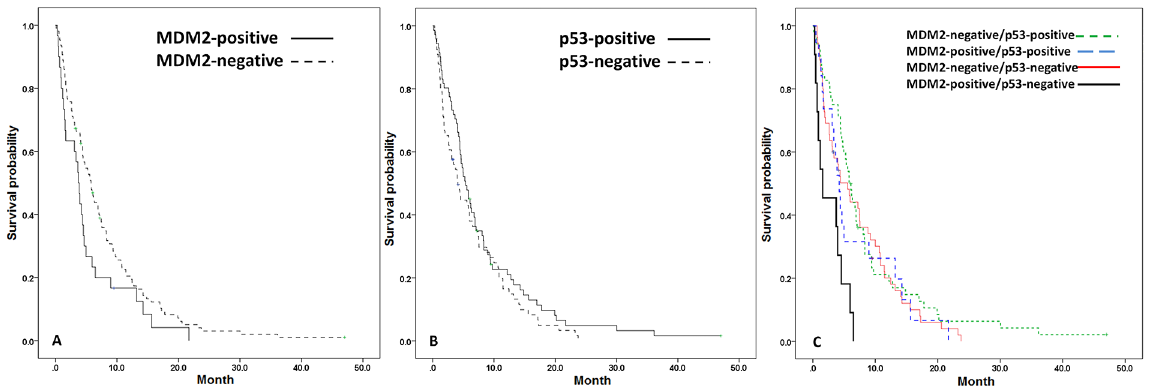
Fig 2. Survival curves in patients stratified with MDM2 and p53. The OS curves stratified with (A) MDM2 expression, (B) p53 expression, and (C) MDM2 and p53 statuses were demonstrated. The dots representedcensoredobservation. The OS was worse in patients with MDM2+ IHC staining( P = .048). The OS did not differ significantly betweenp53+ and p53- patients ( P = .192). After stratification of MDM2 and p53 status, patients with MDM2+/p53- staininghad the shortest OS ( P =